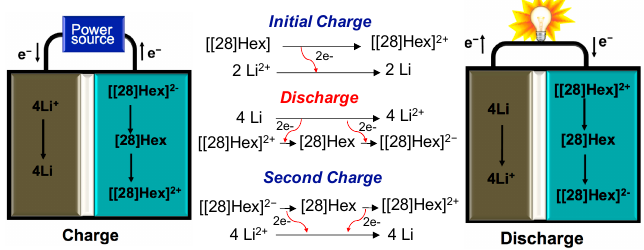
Figure 9. Summary of the charge/discharge reactions for Li-[28]hex battery.